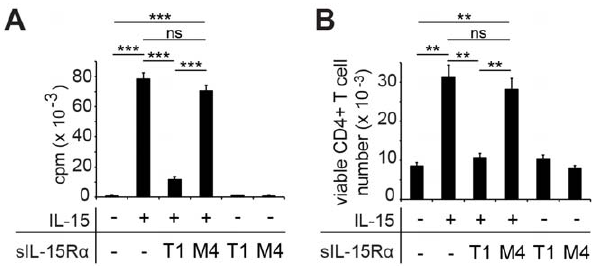
Figure 3. TCR-triggered IL-15-expanded CD4 + T cells remain dependent on IL-15 for expansion and survival. CD4 + T cells were stimulated with 0.1 m g/ml anti-CD3 and irradiated TdACs without or with 3 ng/ml IL-15. After 3 days, 50 ng/ml soluble IL-15R a (sIL-15R a , T1, 50 ng/ml) or control mutated sIL-15R a (M4), lacking IL-15 binding capacity, were added. ( A ) Proliferation of CD4 + T cells, as determined by 3 H-thymidine incorporation of triplicate cultures on day 5. ( B ) Viable CD4 + cell recovery on day 5, determined by flow cytometry. Bar graphs represent the mean 6 SEM. Statistical significance was calculated using student t-test: ns=not significant, ** P , 0.01, *** P , 0.001. Data are representative of three independent